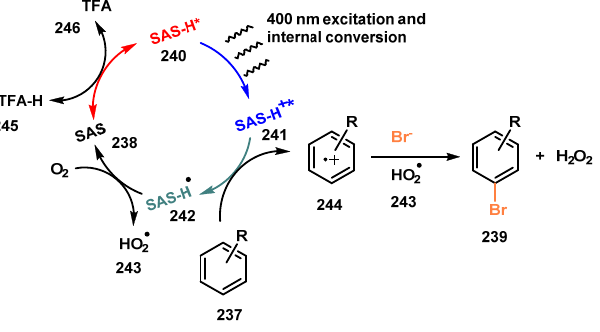
Scheme 64. Mechanism for the photocatalytic bromination of arenes and